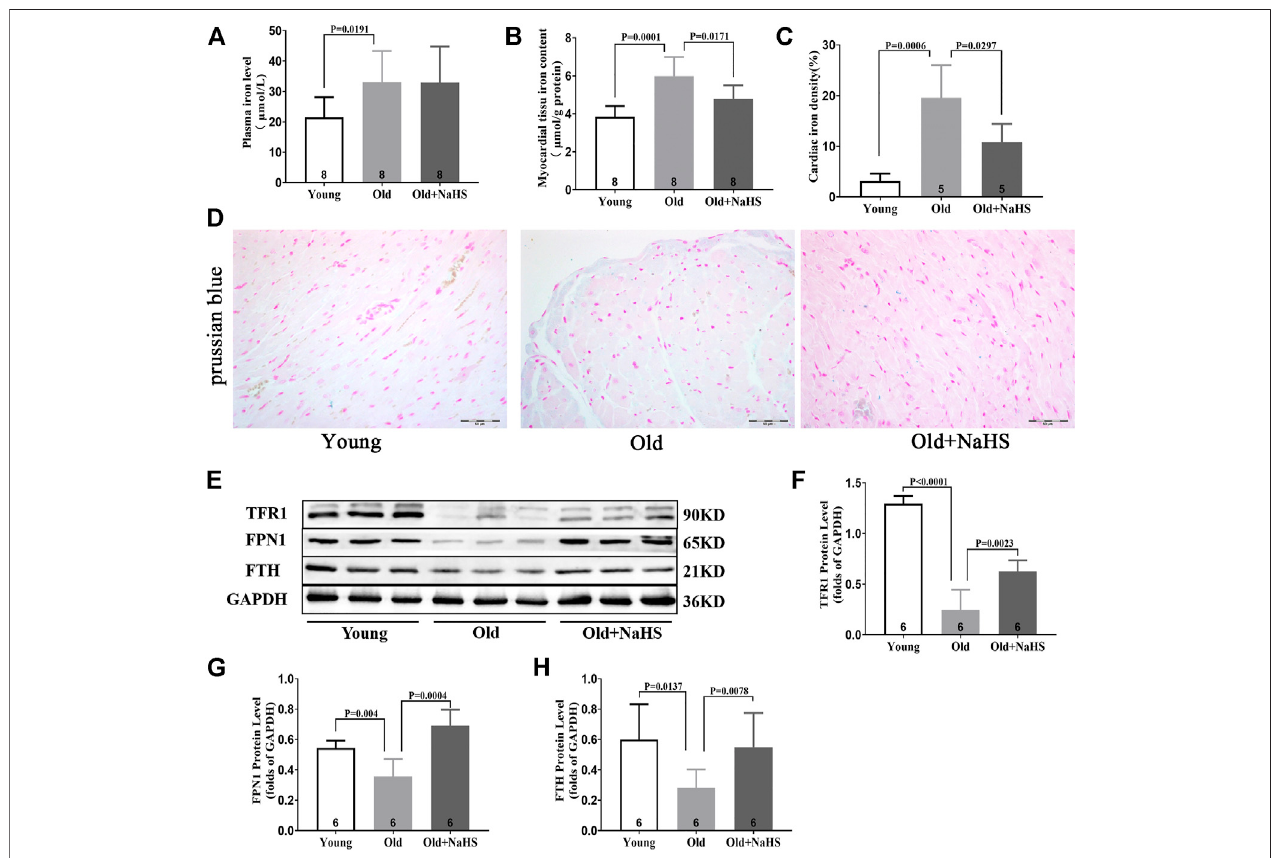
FIGURE 6 | H 2 S regulated iron metabolism and reduced iron accumulation in aging rats. (A) Iron levels in the plasma of aging rats. (B) Iron levels in the myocardial tissue of aging rats. (C) Quantitative data on the Prussian-blue-iron-stained in aging rats. (D) Representative Prussian-blue-iron-stained in myocardial tissue sections of aging rats. (E) Representative Western blots for TFR1, FPN1, and FTH expressions in myocardial tissues. GAPDH was used as the internal control. (F) Quantitative analysis for the TFR1 expression in the myocardial tissue of aging rats. (G) Quantitative analysis for the FPN1 expression in the myocardial tissue of aging rats. (H) Quantitative analysis for the FTH expression in the myocardial tissue of aging rats. Results are means ± SEM. A p -value of < 0.05 was considered signi fi cant.